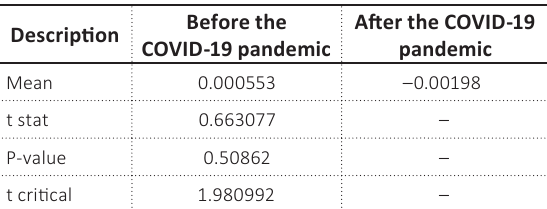
Table 2. The t-test: two-sample with equal